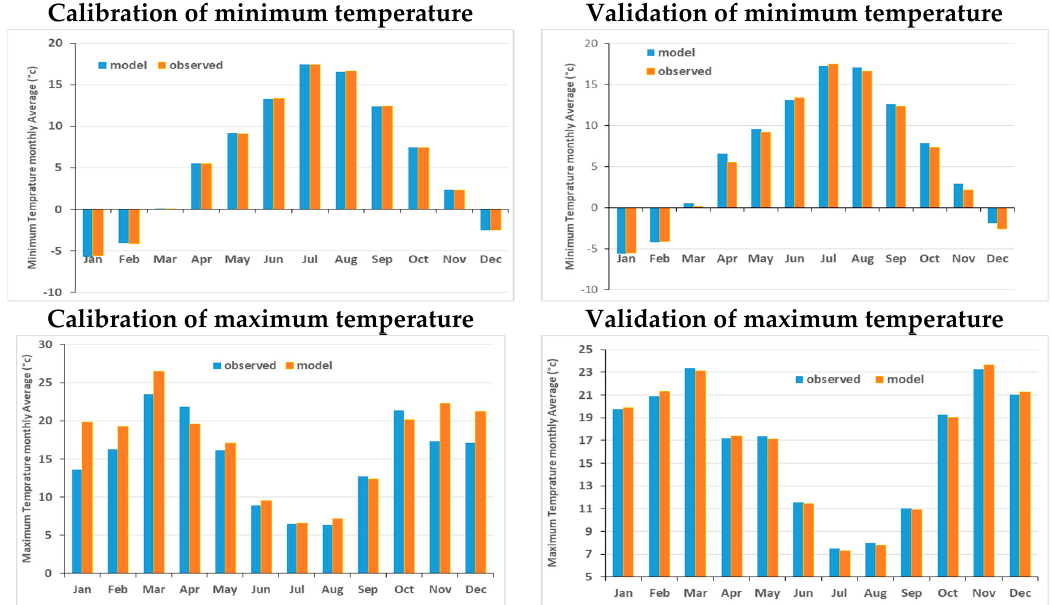
Figure 5. Observed and simulated min. ( upper panels ) and max. ( lower panels ) monthly temperatures for calibration ( left panels ) and validation ( right panels ) periods at 452255t station. Table 4. R 2 and SE of SDSM- downscaled monthly temperatures for calibration and validation periods.